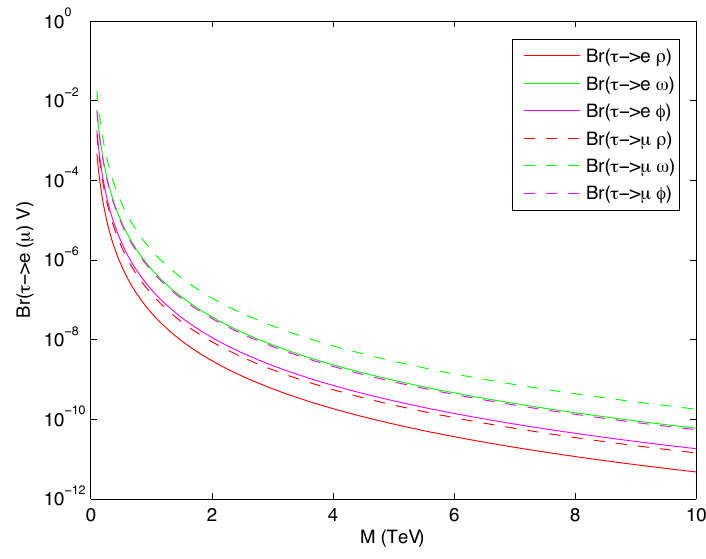
Figure 5 . Dependence of the branching ratios Br( (cid:28) + ! ‘ + V ) on the new neutral gauge boson mass m Z 0 (cid:17) M , where ‘ = e; (cid:22) and P = (cid:26); !; (cid:30) . To produce the (cid:12)gure, lepton mixing angles and phase (cid:18) ‘ = (cid:25)= 3, (cid:18) ‘ = (cid:25)= 6, (cid:18) ‘ = (cid:25)= 4, and (cid:14) ‘ = 0 have been 12 13 23